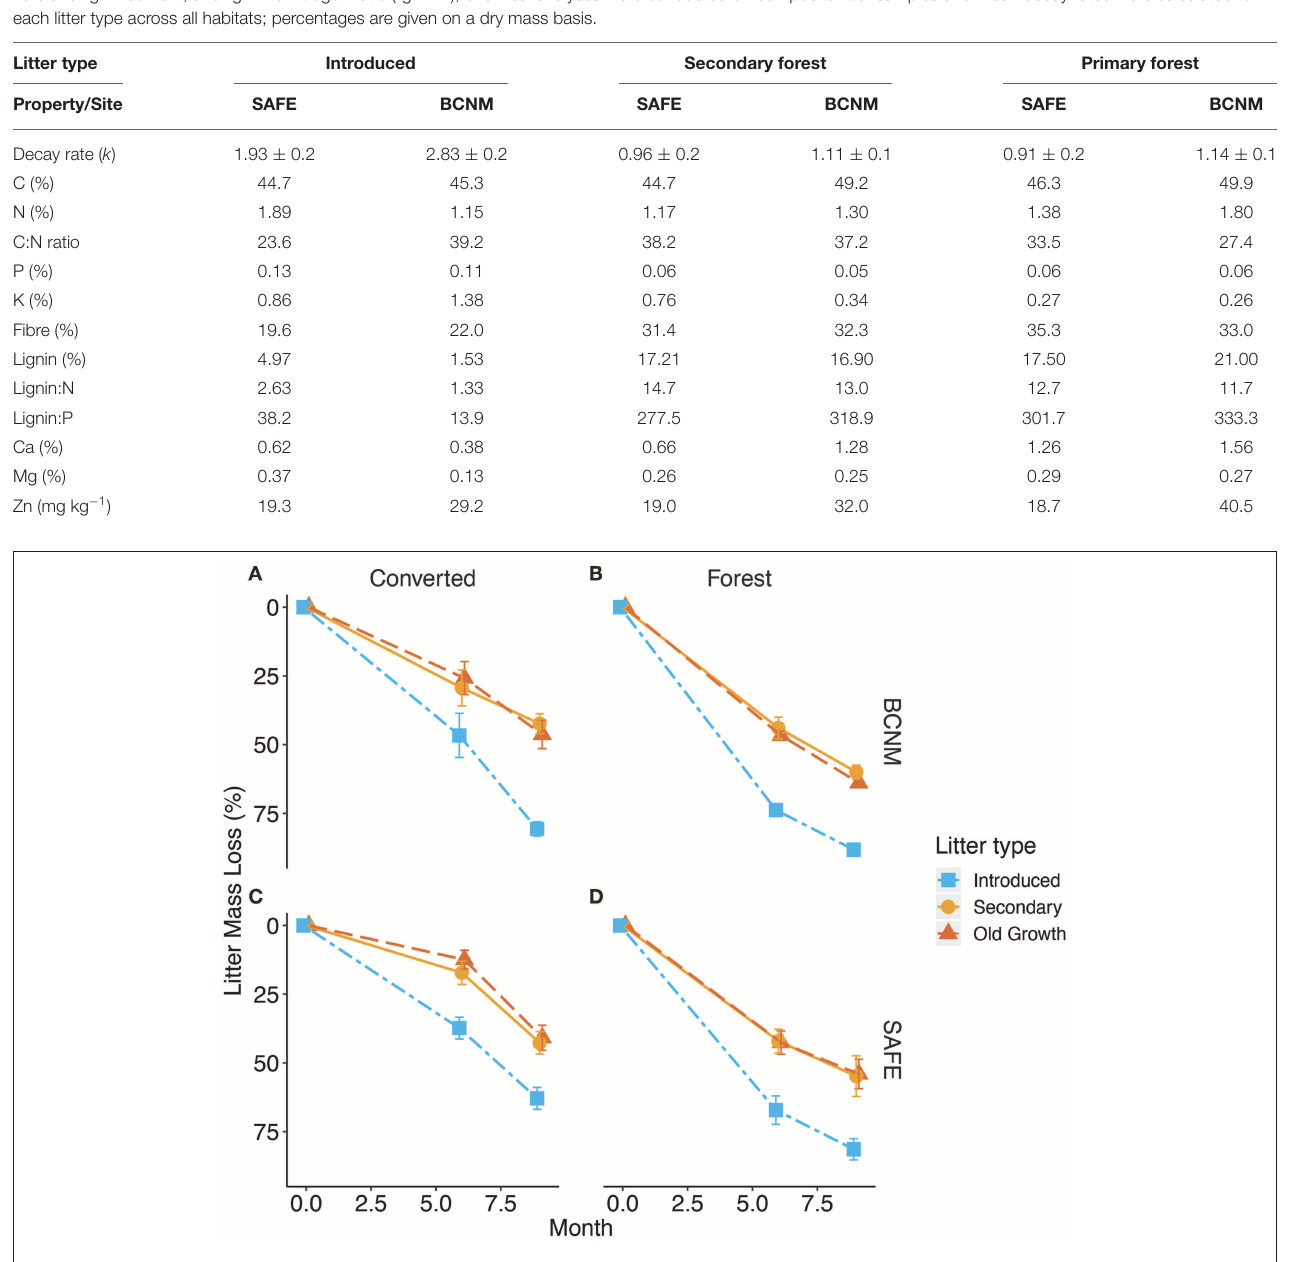
FIGURE 2 | Mass loss during decomposition of three litter types in (A,C) converted habitats and (B,D) forest habitats at BCNM in Panama and SAFE in Malaysian Borneo, respectively. The experiment took place from March to November 2015 at SAFE and from October 2016 to June 2017 at BCNM. Decomposition was measured after 6 and 9 months, where blue squares with dot dashed lines represent introduced litter, orange circles with solid lines represent secondary forest litter and red triangles with dashed lines represent old-growth forest litter; means ± standard errors are shown for n = 6.